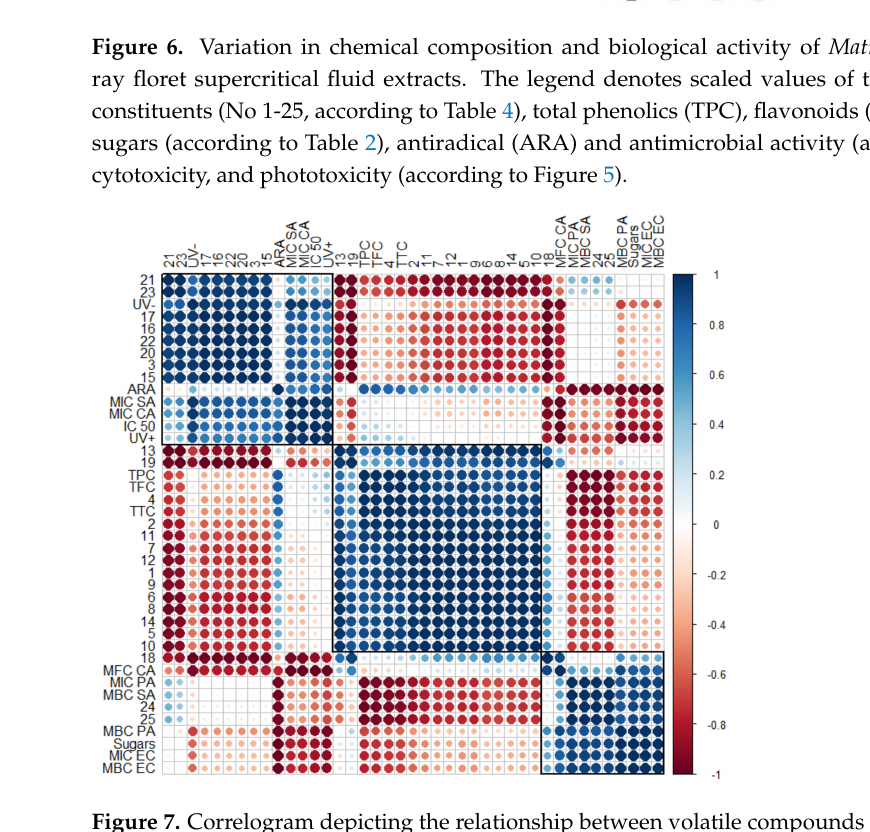
Figure 7. Correlogram depicting the relationship between volatile compounds (No. 1–25, according to Table 4), phytochemical classes (total phenolics (TPC), flavonoids (TFC), tannins (TTC), and sugars, according to Table 2, and their antiradical (ARA) and antimicrobial activity (Table 6), as well as cytotoxicity and phototoxicity (Figure 4). Correlations with p > 0.05 are considered insignificant and are denoted by a white space with a blank. The color and size of the squares are proportional to the correlation coefficients, which are color-coded from deep red ( − 1) to deep blue